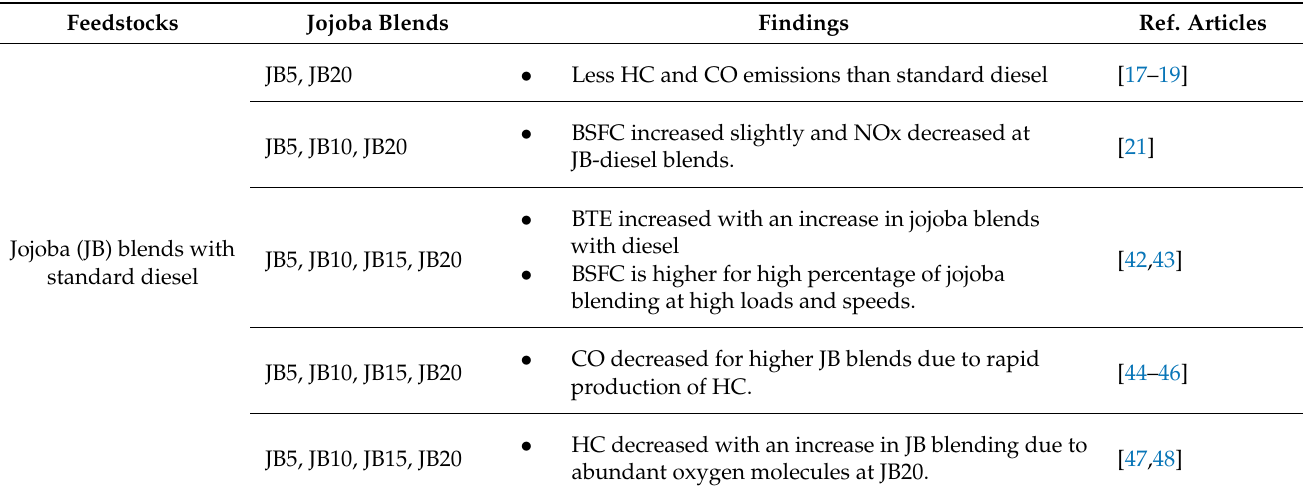
Table 1. Comparison of findings performance and emissions using JB blends with diesel. Feedstocks Jojoba Blends Findings Ref.